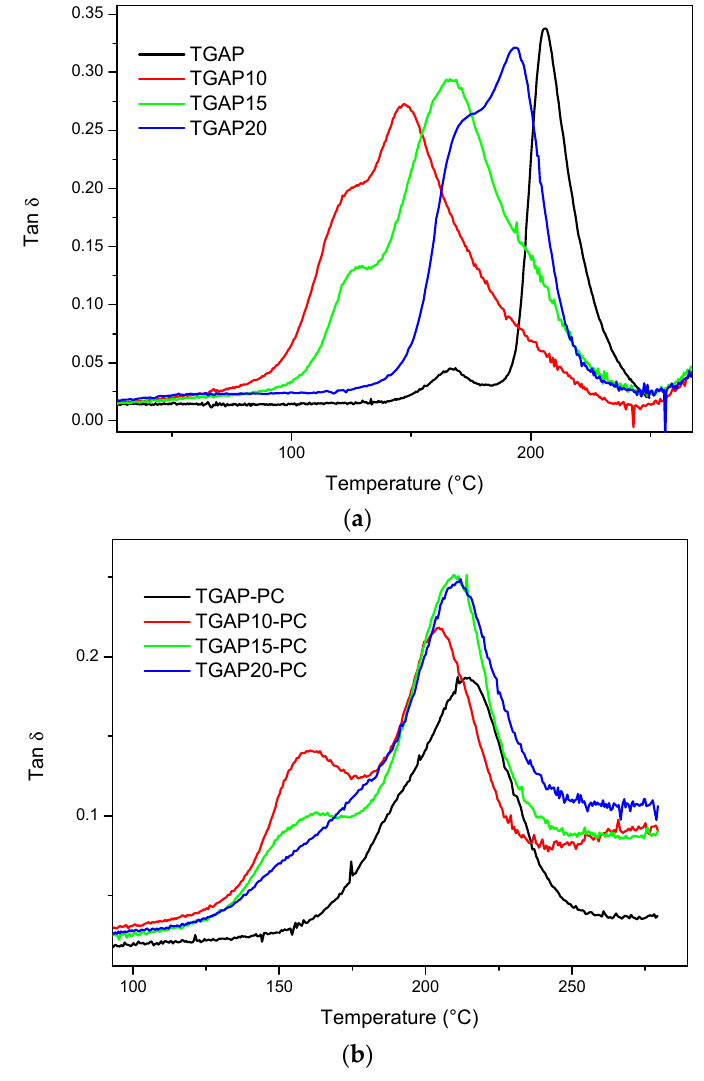
Figure 5. Tan δ versus temperature curves for the neat samples with different veil contents: after curing ( a ); and post-curing ( b ).